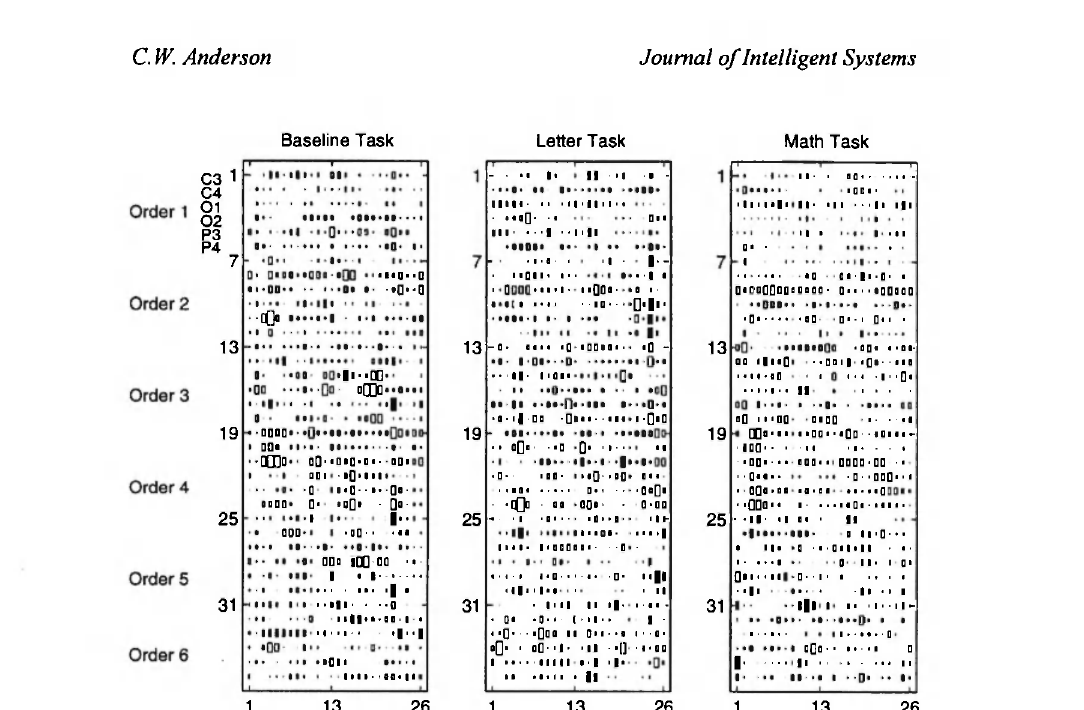
Fig. 4: Normalized AR representation of data shown in Figure 6. Normalized data lie in the range [0,1], but for this figure the mean of 0.5 is subtracted from all values.